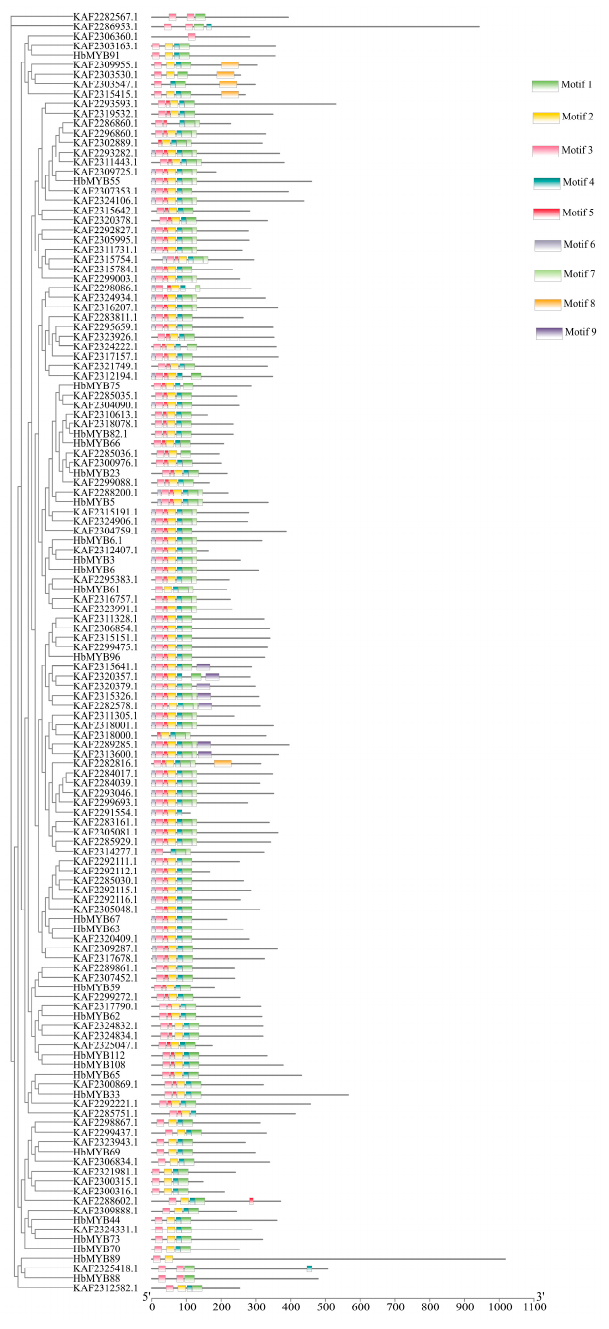
Figure 2. Motif prediction of HbMYBs from rubber tree. The motifs of the 1R, 2R-MYB, and 3R-MYB subfamily proteins were analyzed using the MEME web server. Colored blocks represent 3 kinds of motifs. The length of the gray lines indicates the length of a sequence relative to that of all the other sequences. The position of each block indicates the location of a motif with a matching sequence. The results showed that there were 3 different motifs in the 132 HbMYBs, and the motifs of each sequence are visualized. Squares of different colors represent different motifs and the positions of the